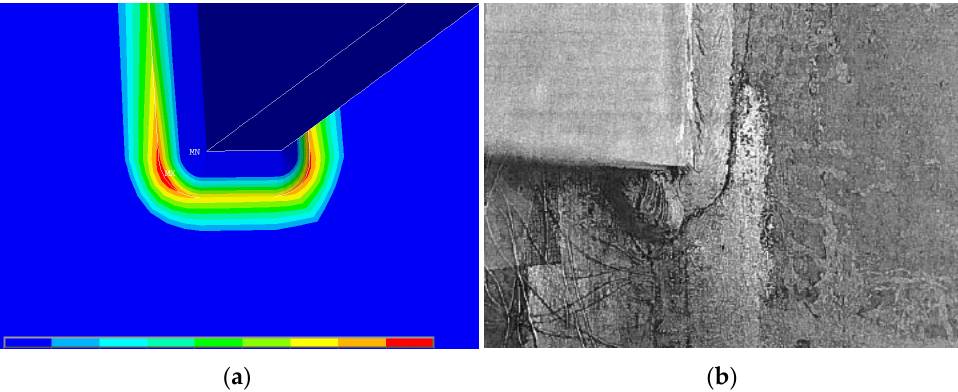
Figure 12. ( a ) Contour-plot of the Equation SS found after the calibration process for a girder specimen series and ( b ) crack pattern around the stiffener termination [49].